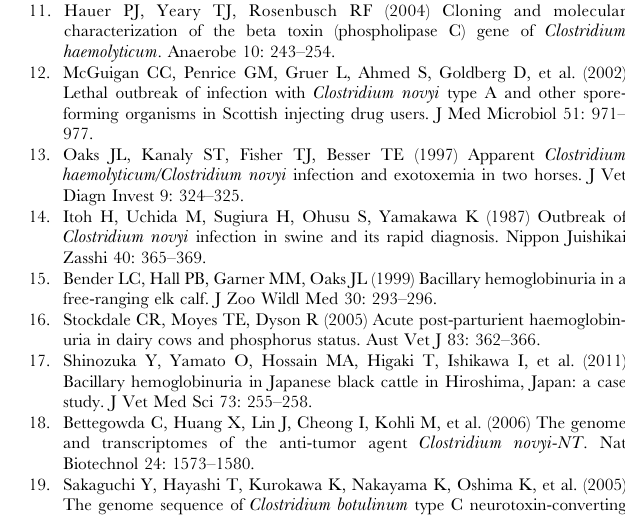
Figure S1 The completed plasmids. Circular representa- tions of the plasmids completed in this study. The circle represents, beginning with the outermost, plus strand genes, minus strand genes, variation in GC and GC skew. Figure S2 PFGE plasmid profiles. Plasmid separation by pulsed-field gel electrophoresis was used to estimate the number of plasmids and their sizes in each strain. DNA from strain